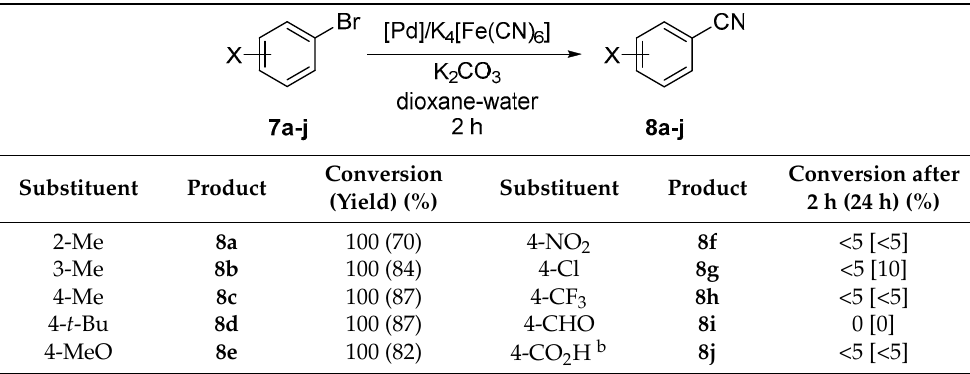
Table 2. Summary of the reaction scope tests. a